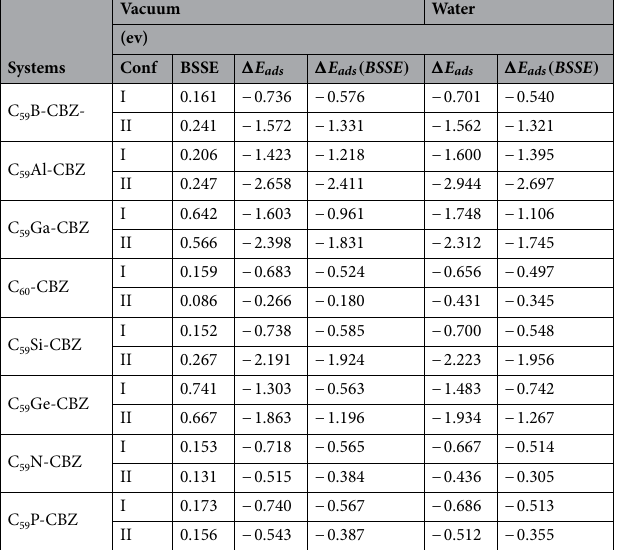
Table 2. Adsorption energy, (cid:31) E ads , with and without BSSE correction for the interaction between CBZ and C 59 X fullerenes as determined at the ωB97XD /6-31 g(d) level of theory. Solvation effects were included by means of the Polarizable Continuum